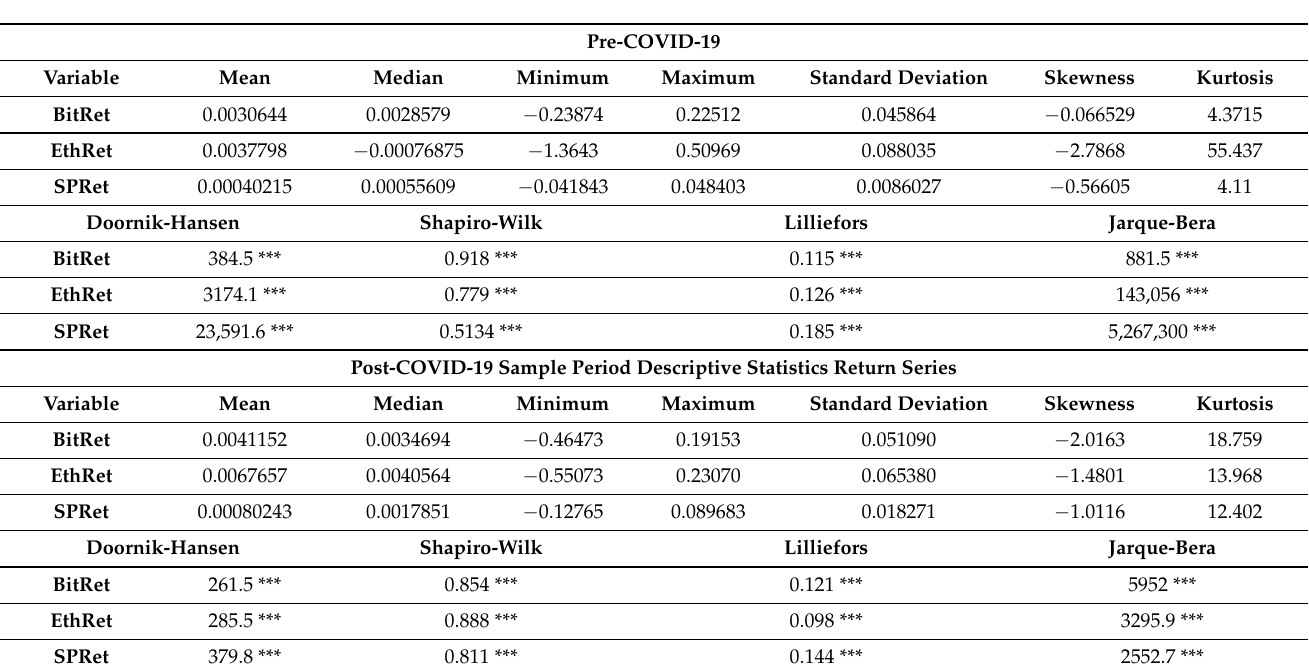
Table 2. Sample period descriptive statistics return series and tests of